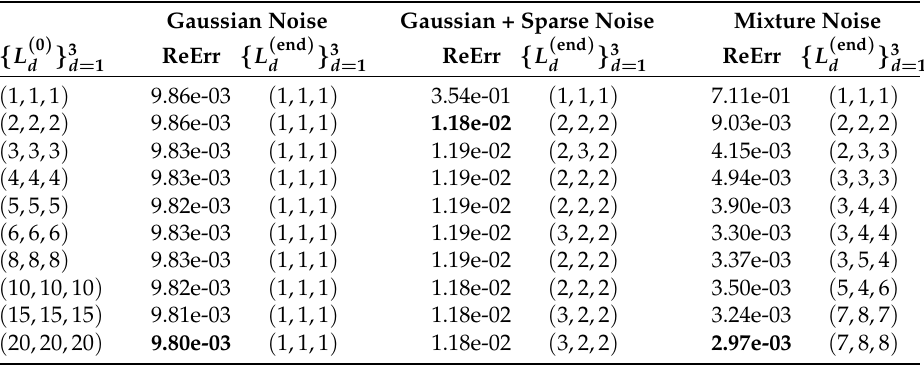
Table 6. ReErr values and estimated numbers of Gaussian components of our method using different initializations of { L d } 3 . This test is based on synthetic data denoising, and the original data are with d = 1 size 50 × 50 × 50 and Tucker rank ( 10,10,10 ) . The best results are highlighted in